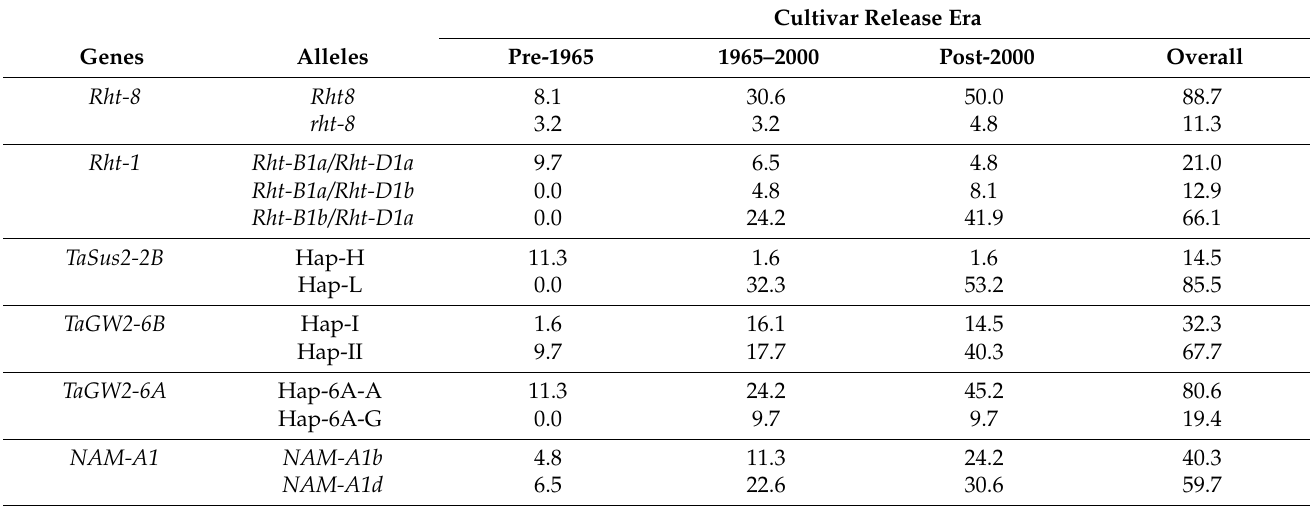
Table 5. Allelic frequencies in percentages for important functional genes in historical wheat cultivars of Pakistan.